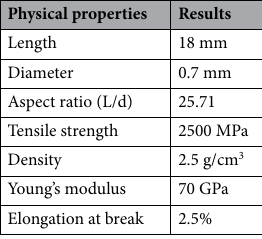
Table 2. Physical properties of glass fibers.